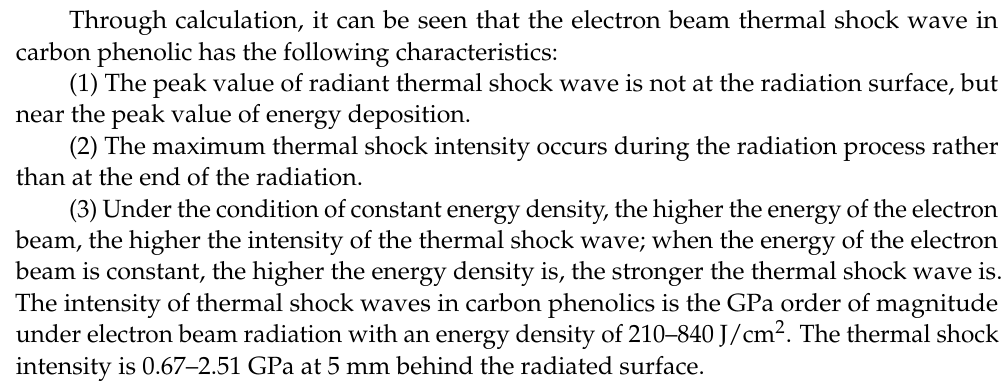
Figure 15. Attenuation of thermal shock waves at different energy densities.